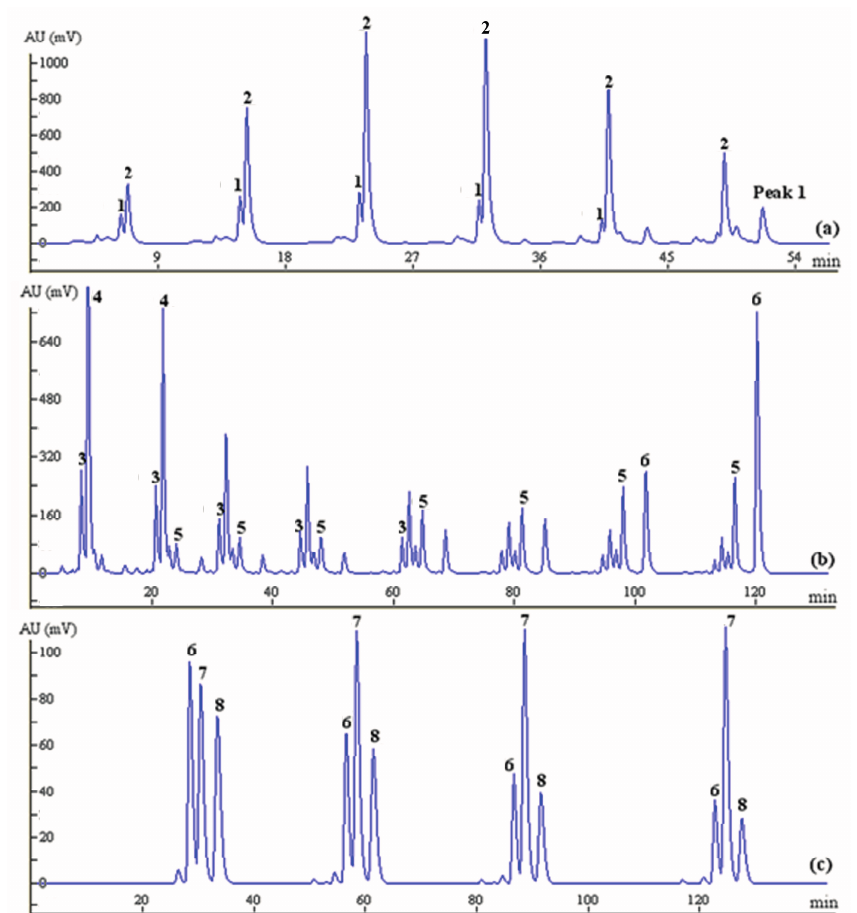
Figure 6. Prep-HPLC chromatograms of 1 and 2 ( a ), 3 and 5 ( b ) and 7 and 8 ( c ) based on offline separation; Peak1shown in (a) was identified as 4 by HPLC